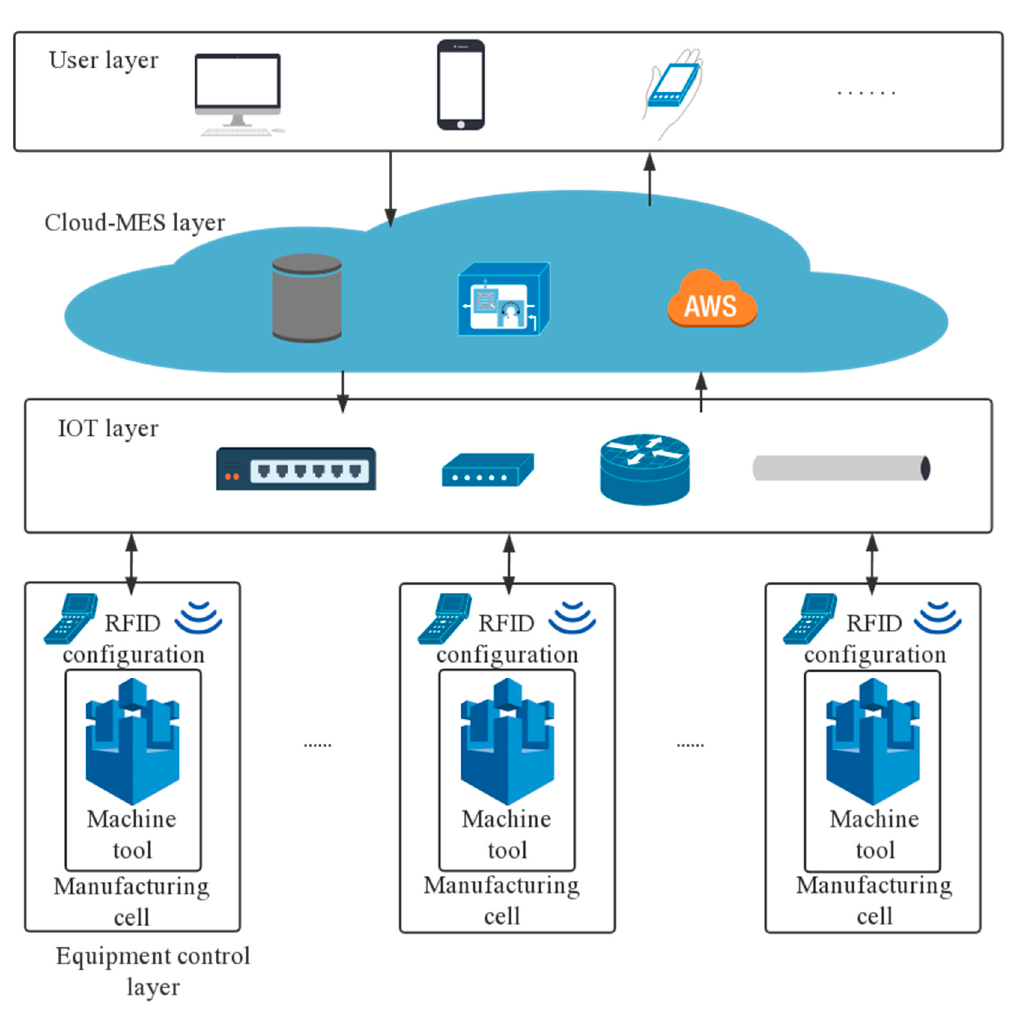
Figure 1. The framework of manufacturing process of cloud MES system diagram centered on machine tools.